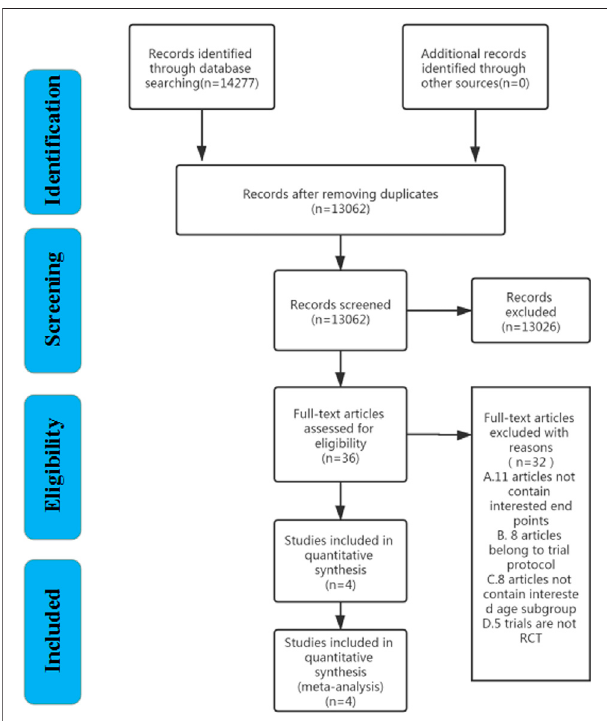
FIGURE 1 | Flow diagram of the literature search and